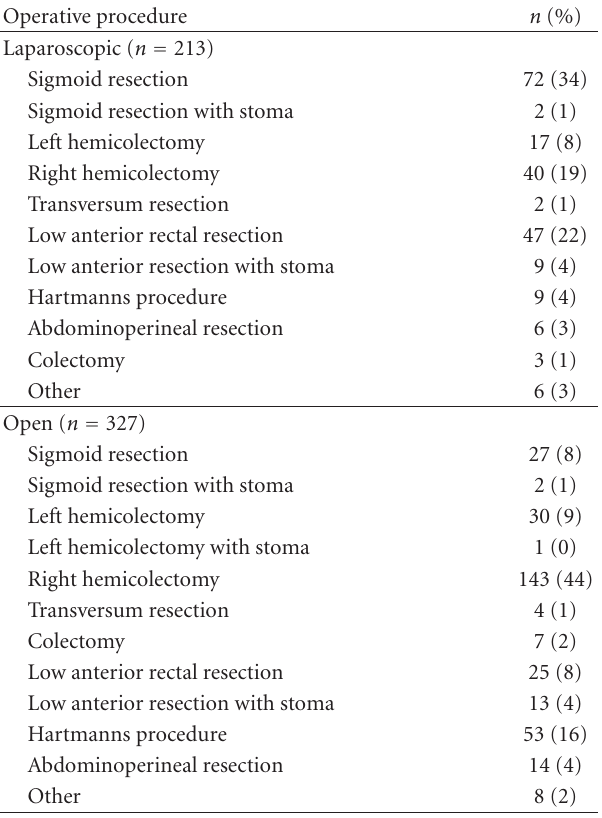
Table 2: Operative